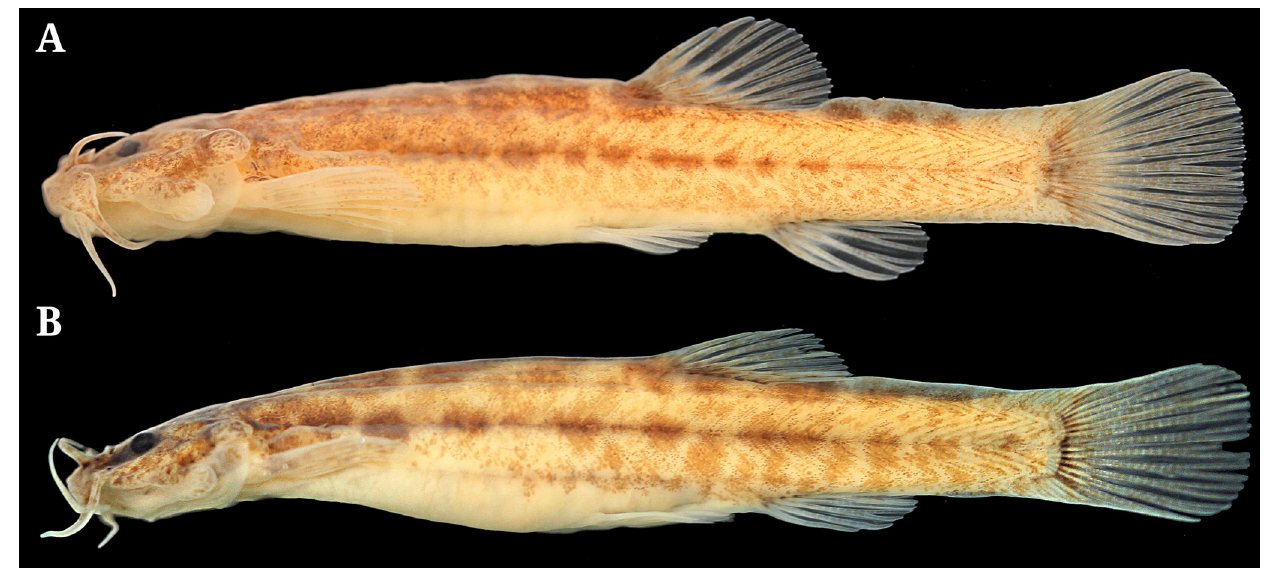
FIGURE 13 | Small specimens of A. Scleronema mate , new species, paratype (UFRGS 17616; 34.3 mm SL) and B. S. teiniagua , new species, paratype (LIRP 16776; 29.3 mm